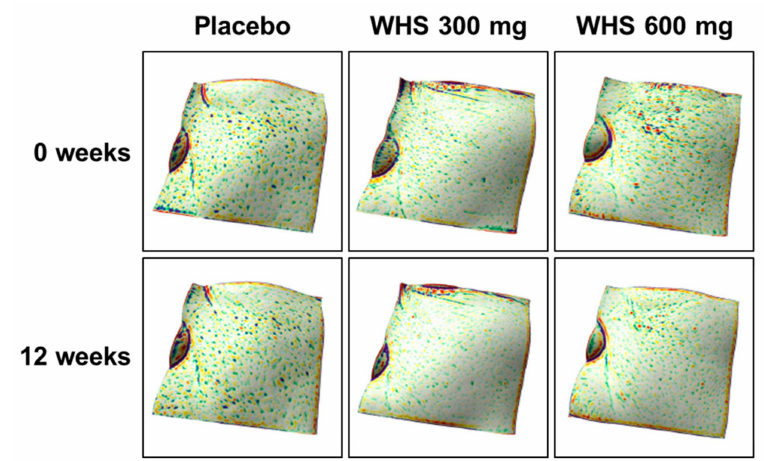
Figure 6. Representative skin texture 3D images with WHS or placebo group after treatment for 12 consecutive